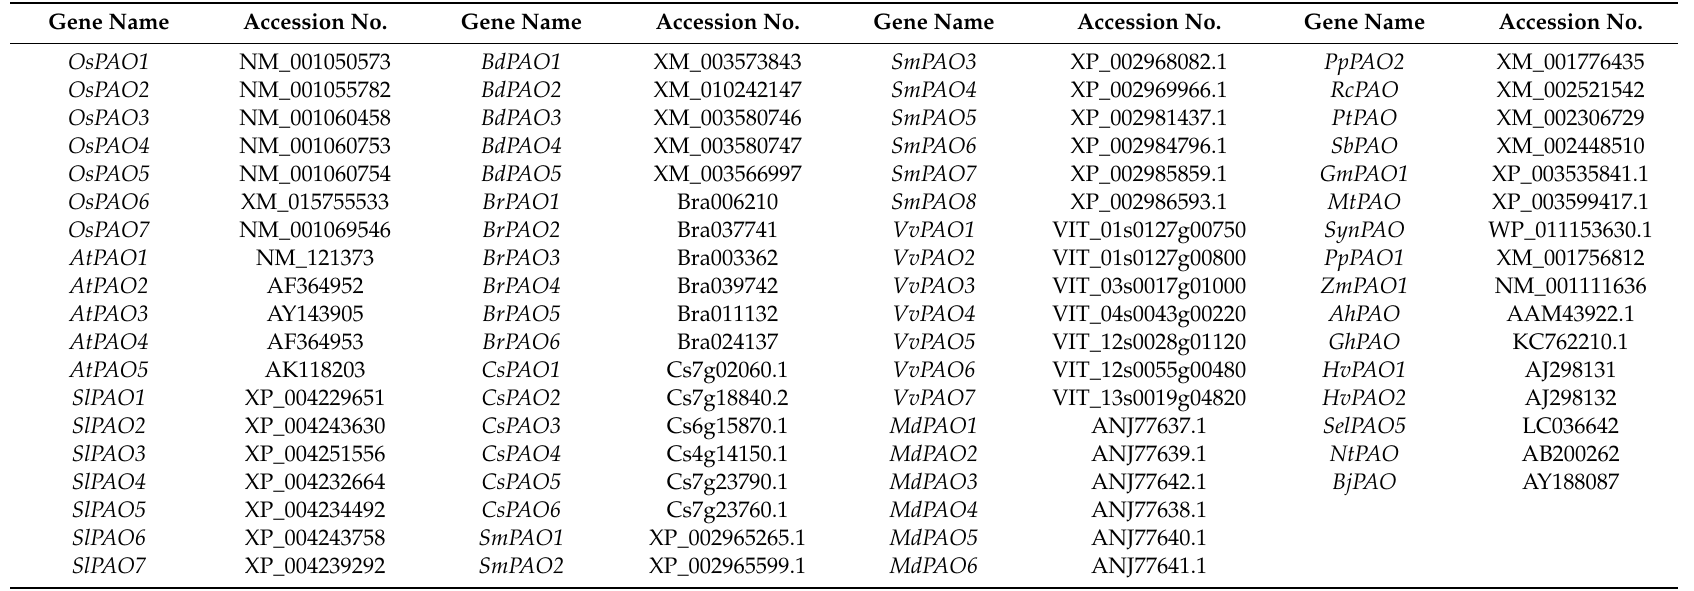
Table 1. List of the accession numbers of the plant PAOs used in Figure